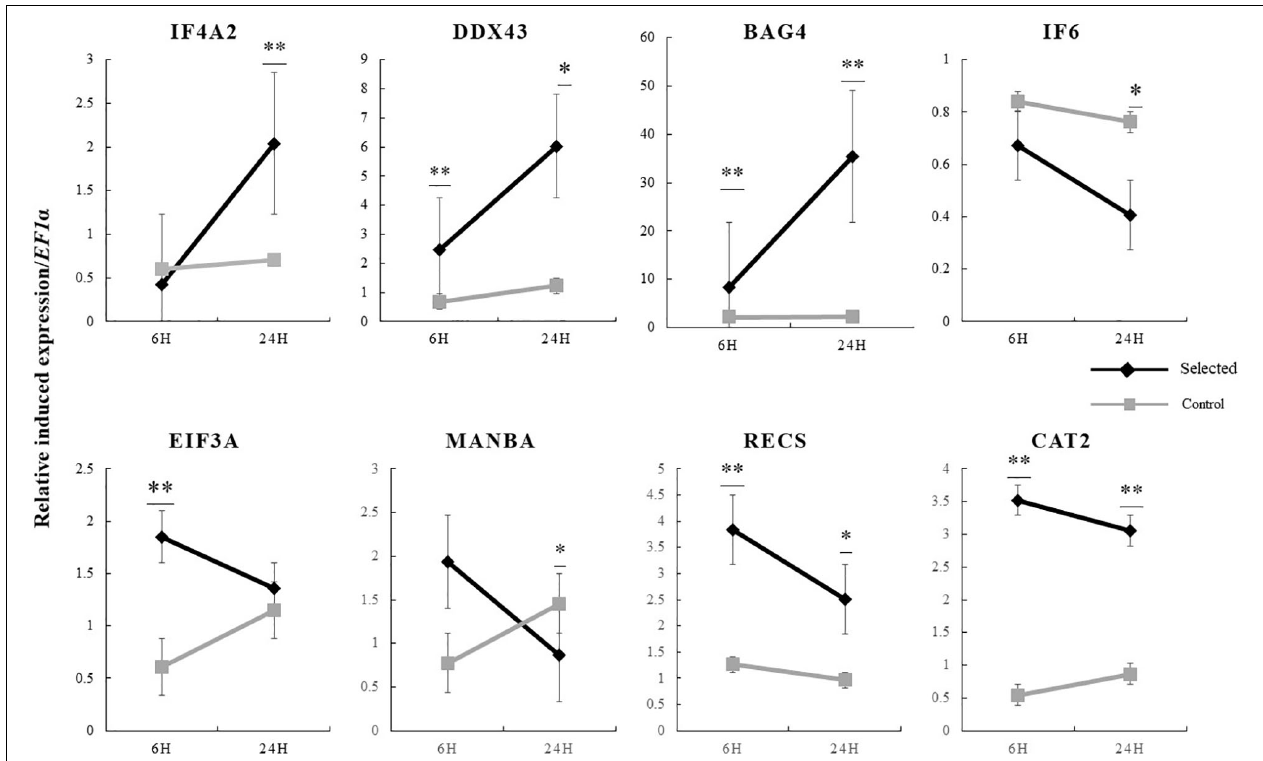
FIGURE 7 | Induced expression of candidate genes at 6 and 24 h in response to heat stress in selected oysters and control oysters ( n = 15) and significance analysis was conducted. ∗ p < 0.05; ∗∗ p <